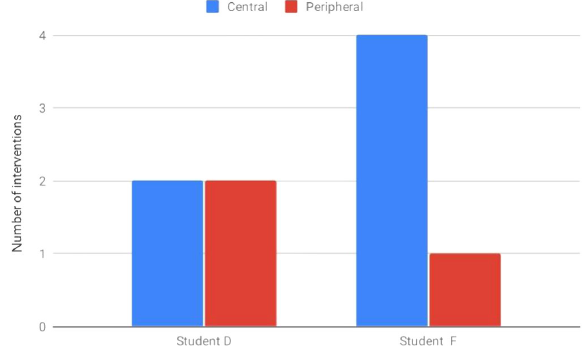
FIG. 9. Types of interventions during segment 3.